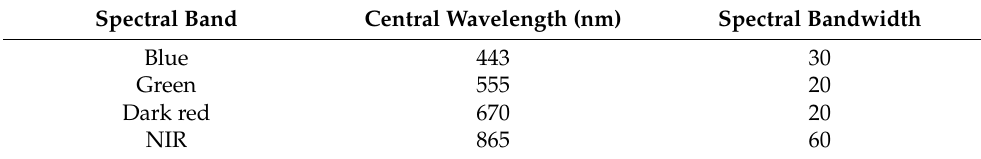
Table 5. Main features of the selected COTS filters for HORUS payload.